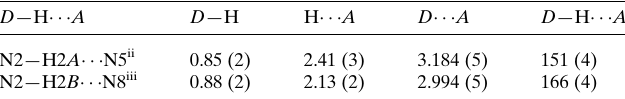
Table 2 Hydrogen-bond geometry (A˚ , (cid:5) ).